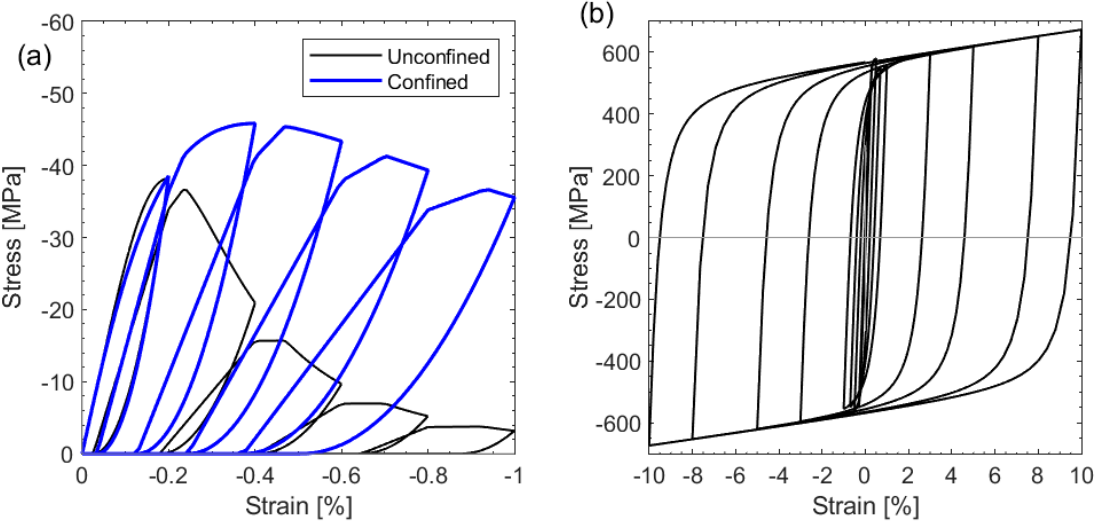
Figure 4. Constitutive stress–strain models for the material models’ ( a ) concrete proposed by Mander et al. [53] (a confinement factor of 1.2 was used) and ( b ) reinforcing steel proposed by Menegotto-Pinto [54]. For these illustrated cyclic (or reverse-cyclic) stress–strain examples, the material properties correspond to those for wall unit UW1.